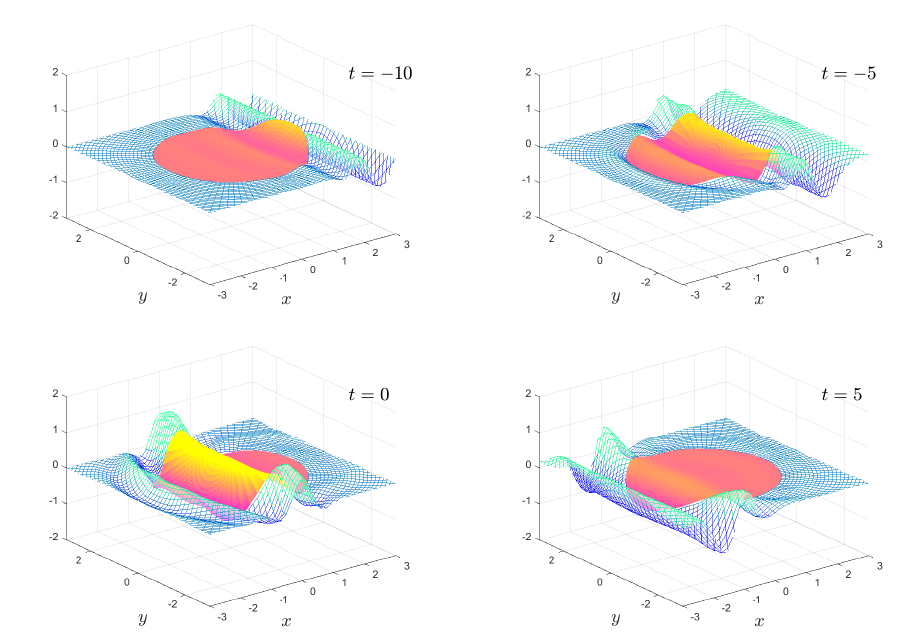
Figure 5. As in Figure 2, except β = 1 × 10 − 4 . The full animation can be found in movie 4.